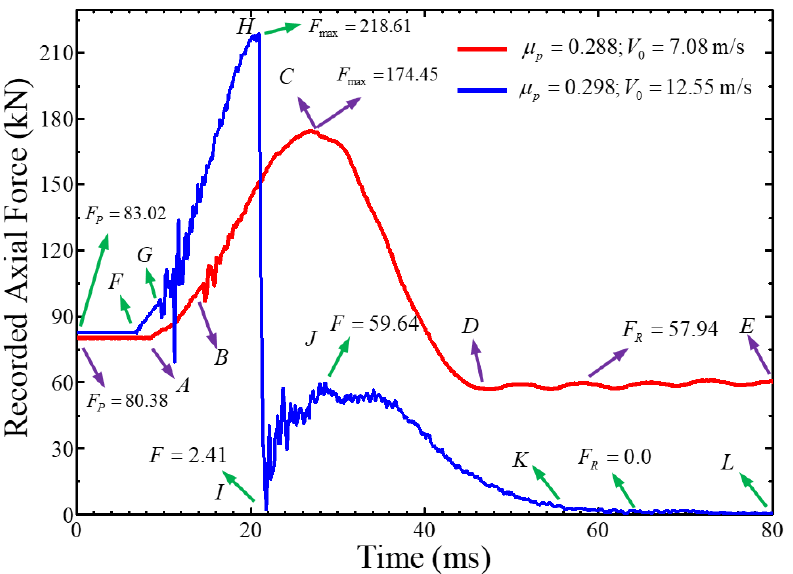
Figure 7. The recorded axial force of strands before and after being subjected to transverse impact under the loading cases of µ p = 0.288; V 0 = 7.8 m/s and µ p = 0.298; V 0 = 12.55